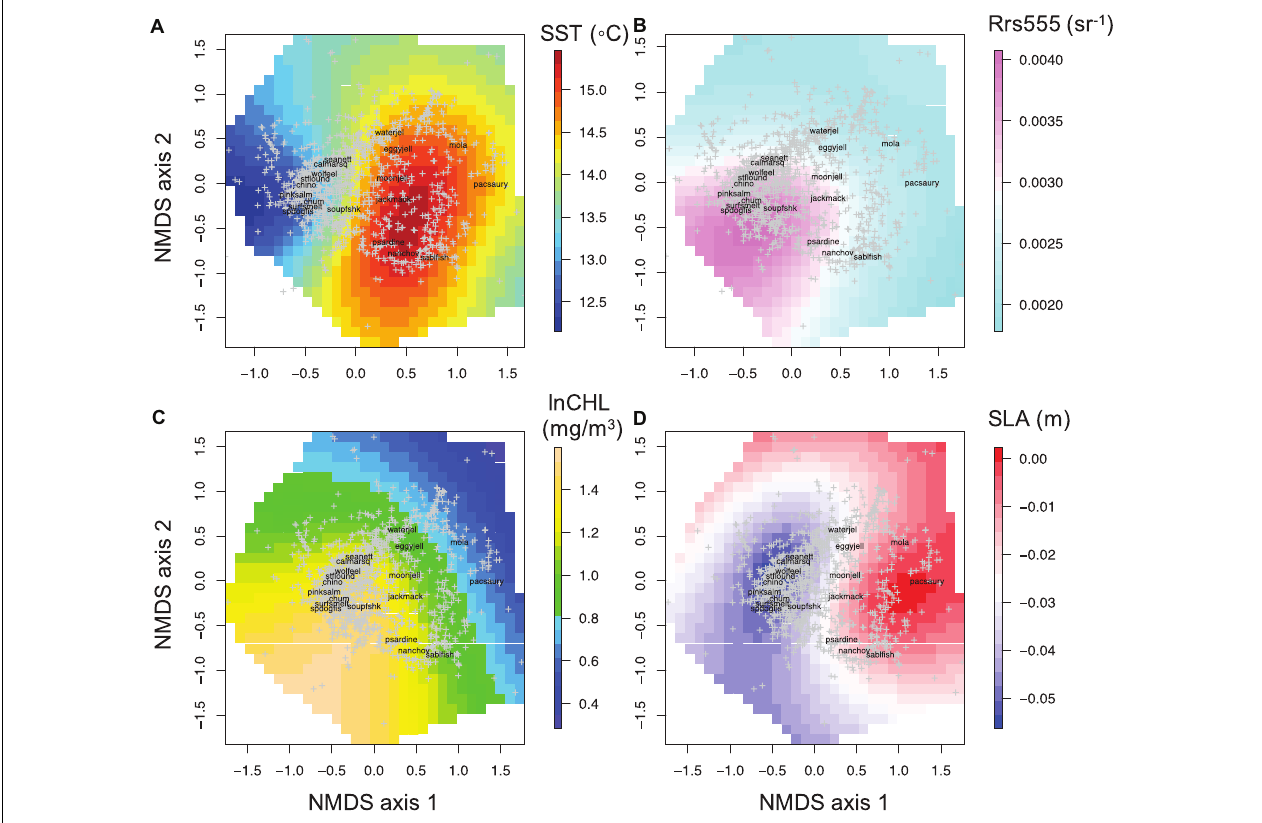
FIGURE 4 | Non-linear relationships of remotely sensed oceanographic variables with the epipelagic Northern California Current community structure. Colors denote a gradient along each environmental variable in two dimensions overlain on the ordination; (A) sea surface temperature; SST ( ◦ C), (B) remote sensing reflectance